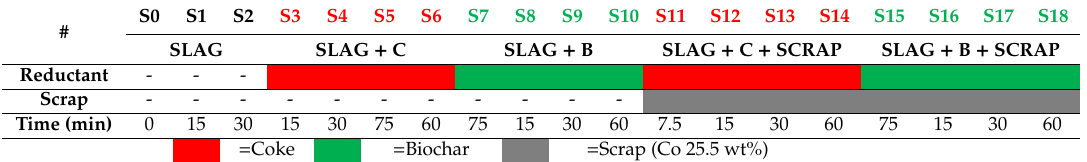
Table 3. Sample numbering and series naming with the varying experimental parameters: the reductant employed, possible addition of scrap and high-temperature contact